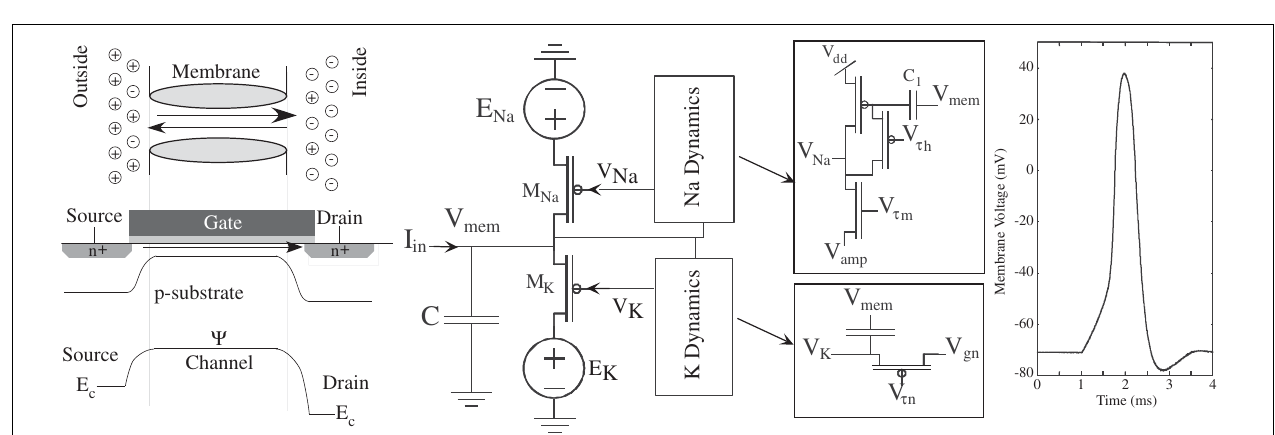
the drain. The band diagram of silicon has a similar shape to the classical model of membrane permeability proposed by Hille (2001). This approach yields an updated model for modeling biological channels that also empowers dense MOSFET implementation of these approaches. The primary design constraint is modeling the gating function with other transistor devices; such an approach is shown to model the classic Hodgkin–Huxley squid axon data, resulting in a close model to the action potential, as well as voltage clamp